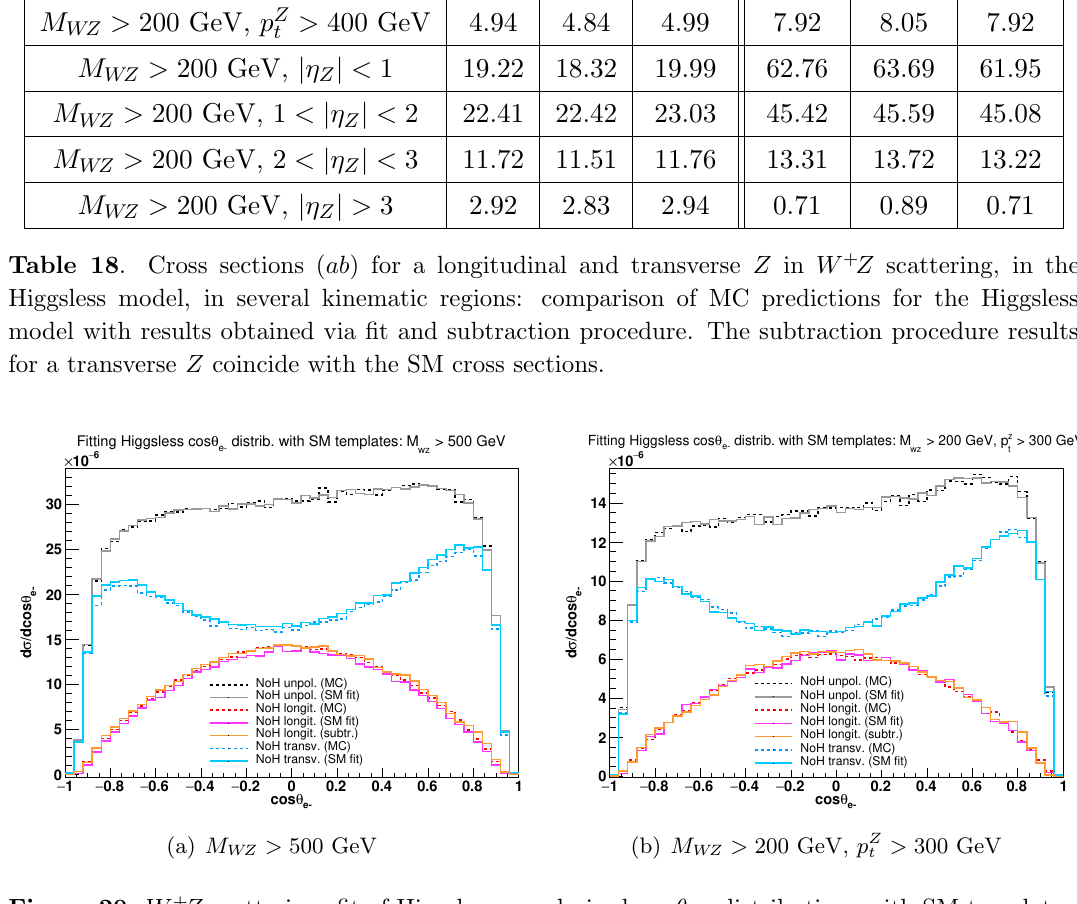
distributions with SM templates, e (cid:0)